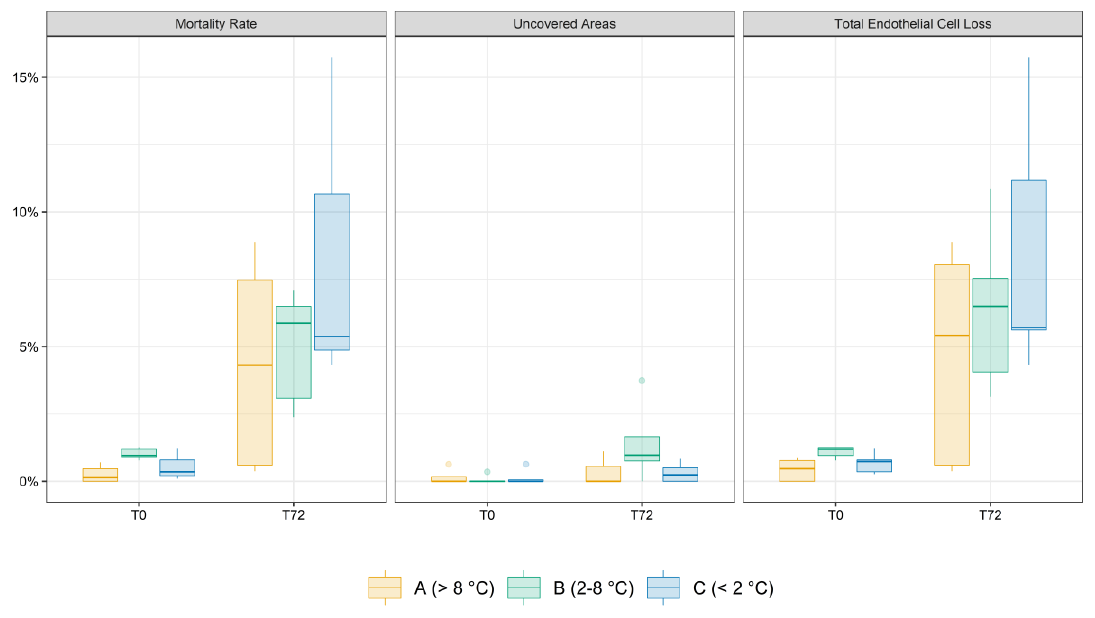
Figure 2. Boxplots displaying the distribution of mortality rate, uncovered areas and total Endothelial Cell Loss (ECL) in the three groups at T0 and T72. The solid lines represent the median, the boxes span the 25th and 75th quantile, the whiskers of the boxes extend to 1.5 times the interquartile range, and solid dots represent outliers. Only mortality rate was significantly different among the three groups at T0, and post hoc pairwise comparison showed that it was significantly greater in group B compared to group A ( p = 0.01). At T72, mortality rate and total ECL showed a trend for inversely proportional correlation to temperature, although these differences did not reach statistical